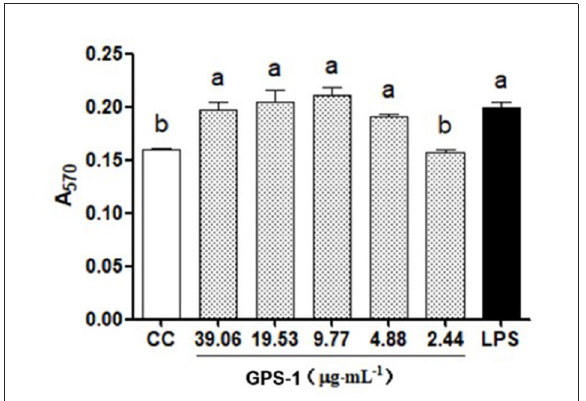
FIGURE2 GPS-1 effects on the proliferation of chicken dendritic cells (A570). a,b Values in the same column with different superscript letters differ significantly at p <